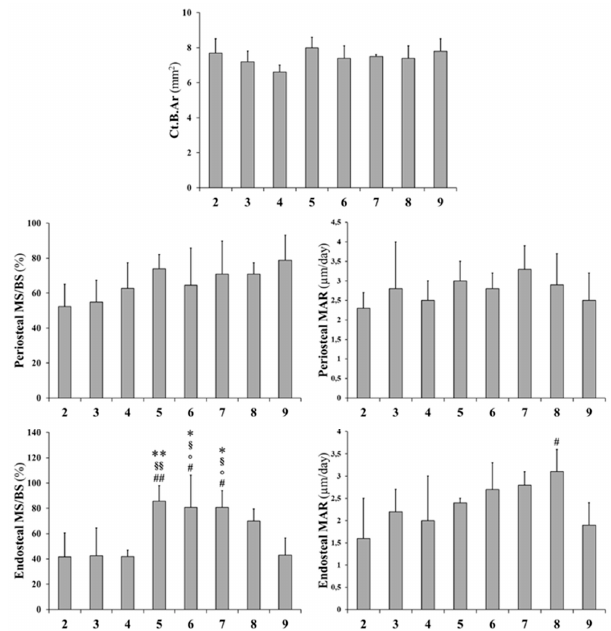
Figure 6. Static and dynamic histomorphometric parameters of cortical bone in mid-diaphyseal femoral sections. Ct.B.Ar: cortical bone area; MS/BS: mineralizing surface; MAR: mineral apposition rate. Values are expressed as mean ± S.D. ANOVA followed by Bonferroni’s test. # p < 0.05, ## p < 0.01 versus Group 2; ° p < 0.05 versus Group 3; § p < 0.05, §§ p < 0.01 versus Group 4; * p < 0.05, ** p < 0.01 versus Group 9.